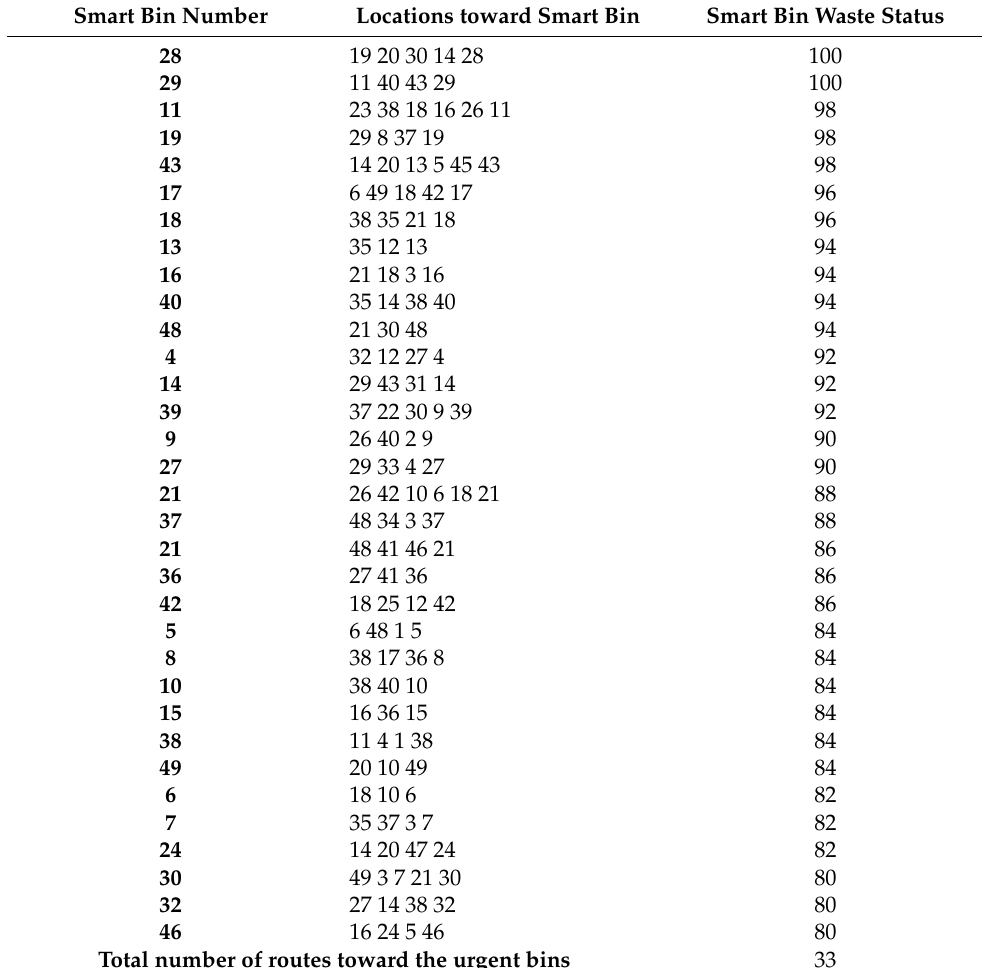
Table 5. Urgent smart bins needed to be cleaned-Type